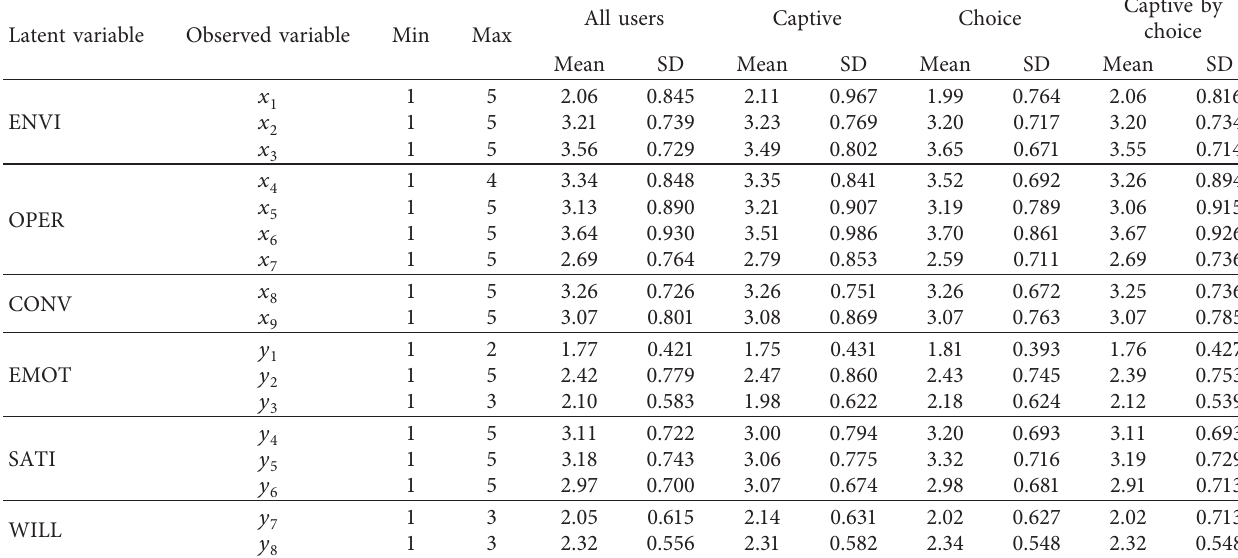
Table 4: Statistical results of observed